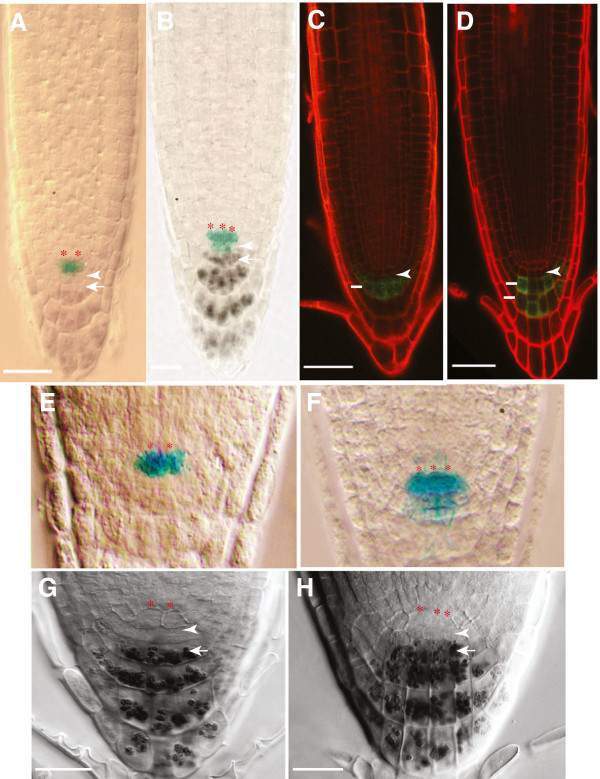
QC size but not patterning is altered in spt-11. Micrographs of 5 DAG roots. (A, C, E) Col-0. (B, D, F) spt-11. (A, B) Expression of QC25::GUS (blue) in the QC and starch in the differentiated columella. Red asterisks indicate QC cells, arrowheads indicate root cap initials and arrows indicate first row of columella cells. (C, D) Expression of the columella marker QC1630::GFP in propidium iodine-stained roots. Arrowheads indicate root cap initial cells and lines indicate stained columella cell layers. (E, F) Close-ups of the roots shown in A and B to highlight expression of QC25::GUS. Red asterisks indicate QC cells. (G, H) Micrographs of 5 DAG roots stained for starch. (G) L. er. (H) spt-2. Red asterisks appear above cells in the QC. Arrow indicates starch staining in the root cap. Arrowheads indicate columella and epidermal/lateral root cap cells. Scale bars indicate 100 μm.